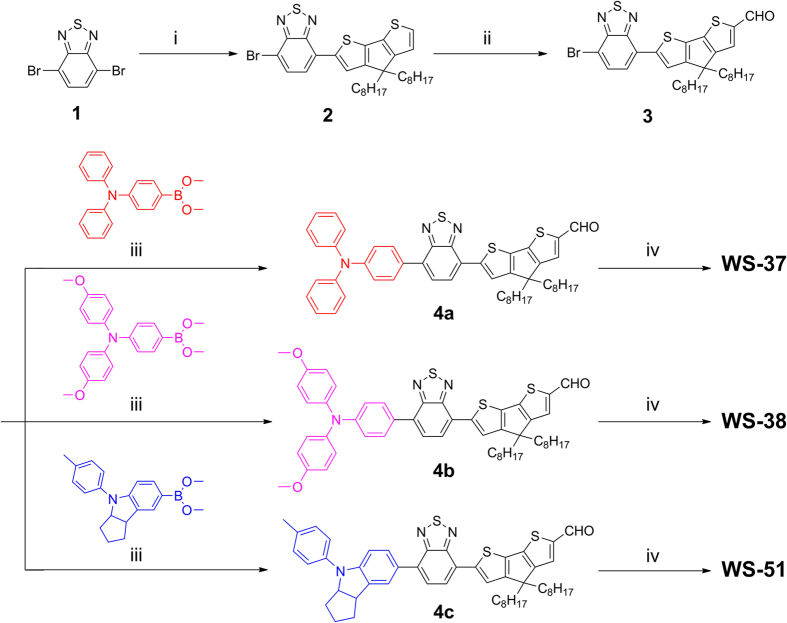
Synthetic route to WS-37, WS-38 and WS-51.Reaction conditions: i) Pd(PPh3)4, 2 M K2CO3 aqueous solution, THF, Ar, 90 ºC, ii) POCl3, DMF, 25 ºC, iii) Pd(PPh3)4, 2 M K2CO3 aqueous solution, THF, Ar, 90 ºC, and iv) piperidine, acetonitrile, Ar, 90 ºC.